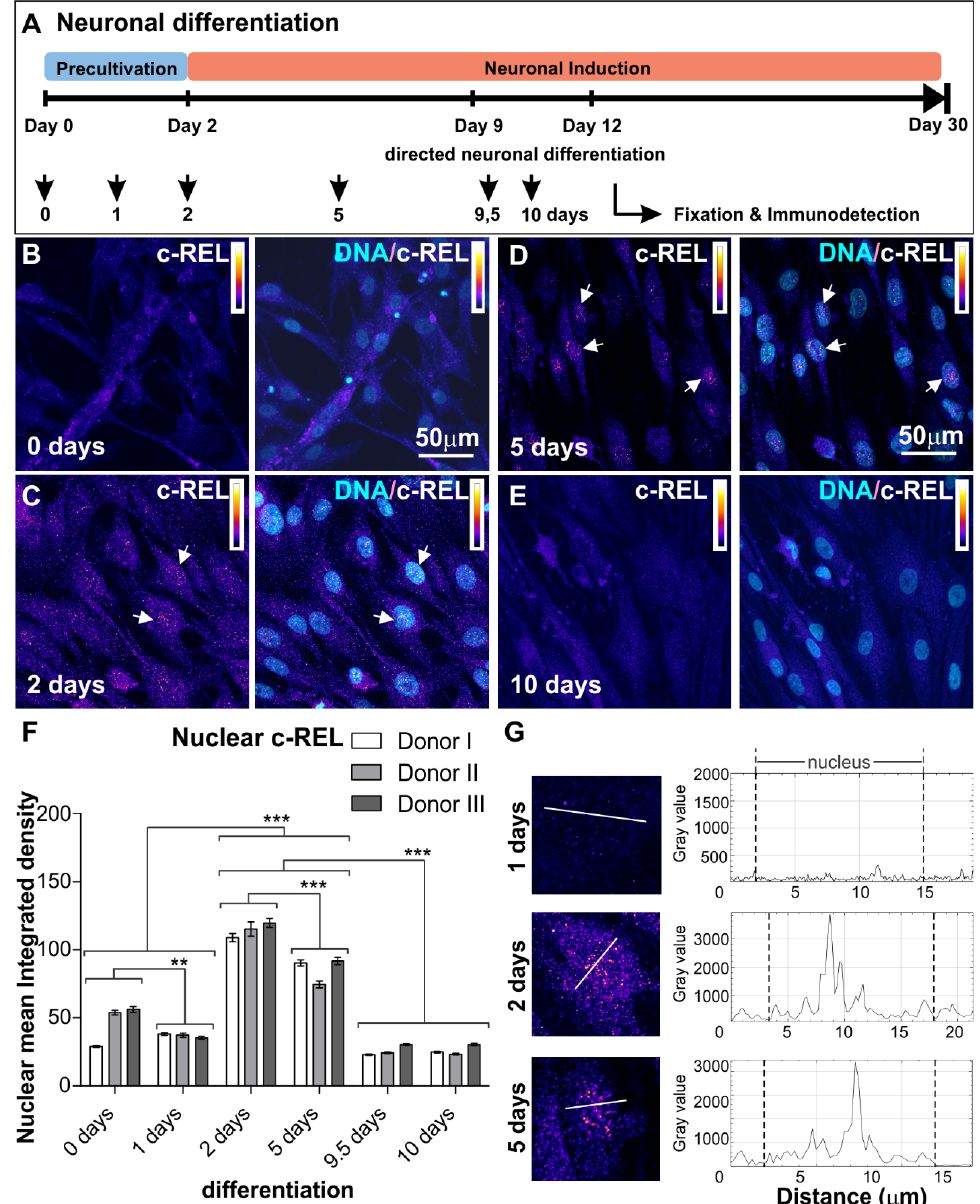
Figure 1. Immunocytochemical analysis of c-REL. ( A ) Neuronal differentiation procedure. Adult human NCSCs were differentiated into NSCs and further into glutamatergic neurons. NF- κ B subunit composition was analyzed at different time points as indicated. ( B – E ) NCSC-derived NSCs labeled against c-REL after 0, 2, 5 and 10 days of glutamatergic differentiation respectively. Each panel shows c-REL (left) and DNA colocalization (right). Intensity scale indicating white and black as highest and lowest intensity levels. Arrows depict c-REL-nuclear activation. ( F ) Quantification of immunocytochemical analyses showing c-REL nuclear mean integrated density during early differentiation ( n = 3, mean ± SEM). Normality was refuted using Shapiro-Wilk normality test. Nonparametric Kruskal-Wallis (*** p ≤ 0.001) and Bonferroni corrected post-test (*** p < 0.001) revealed significantly increased nuclear translocation of NF- κ B-c-REL on days 2 and 5. ( G ) Fluorescence intensity profiles measured at three different time points (1, 2 and 5 days of differentiation) for cells following transects as shown clearly revealed the difference between nuclear and cytoplasmic fluorescence. NCSCs: neural crest-derived stem cells, NSCs: neural stem cells.